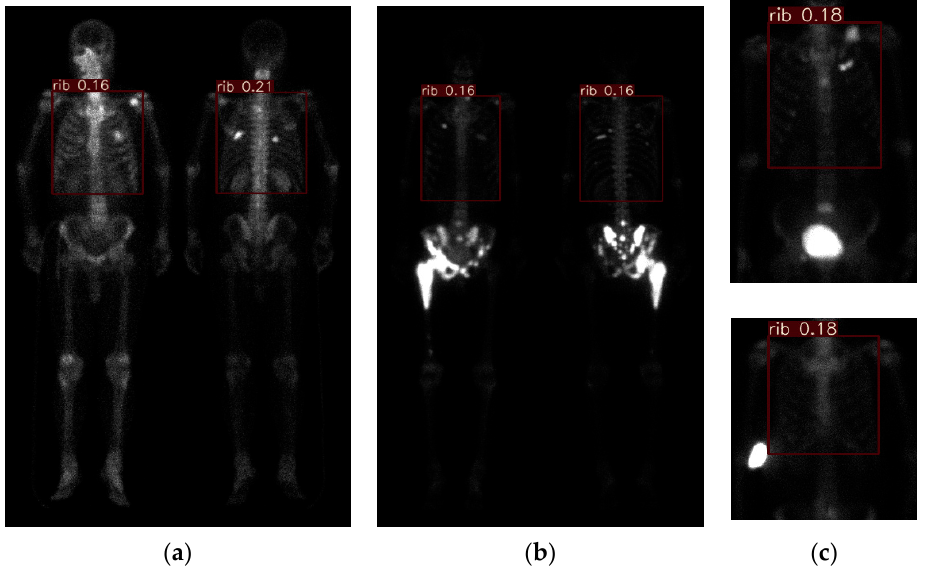
Figure 3. Without a loss of generality, several extreme results of image pre-processing are shown. ( a ) result (case number 9) representing most cases; ( b ) pelvic metastasis with strong Tc-99m MDP absorption (case number 13); ( c ) urine remaining in the bladder (case number 71) and injection leakage (case number 60).